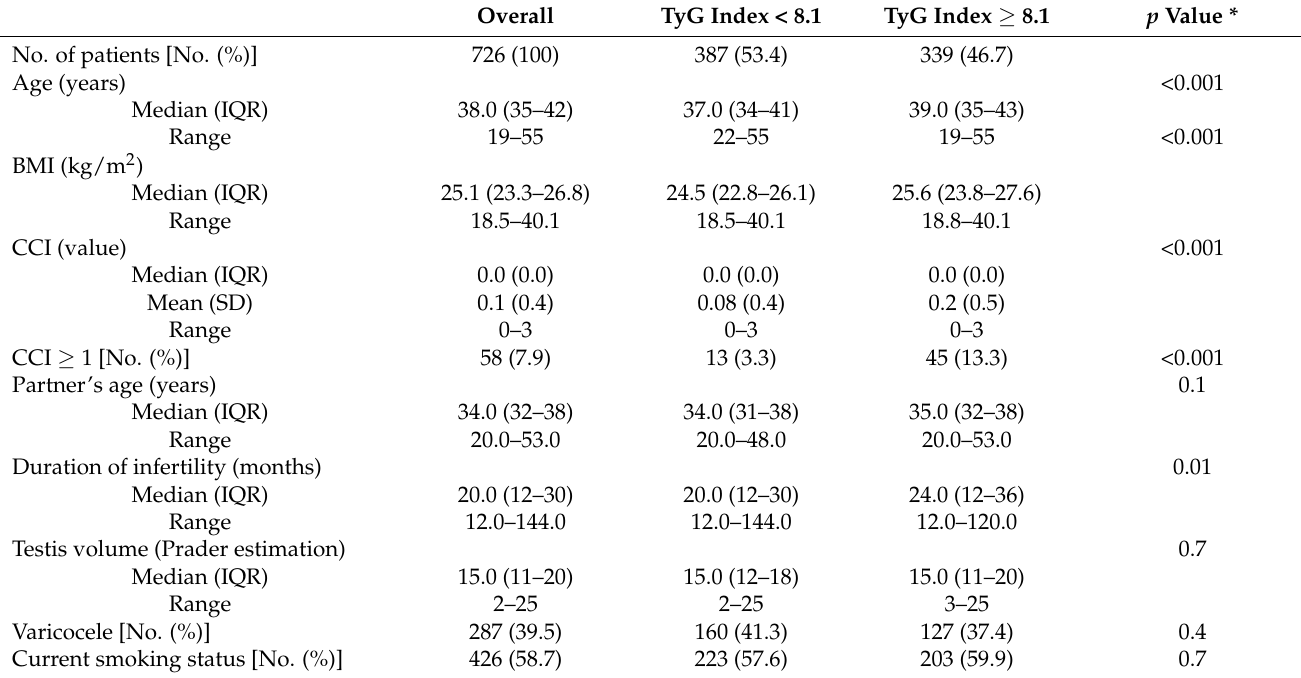
Table 1. Demographic characteristics of the whole cohort of infertile patients according to TyG index suggesting insulin resistance ( N = 726).